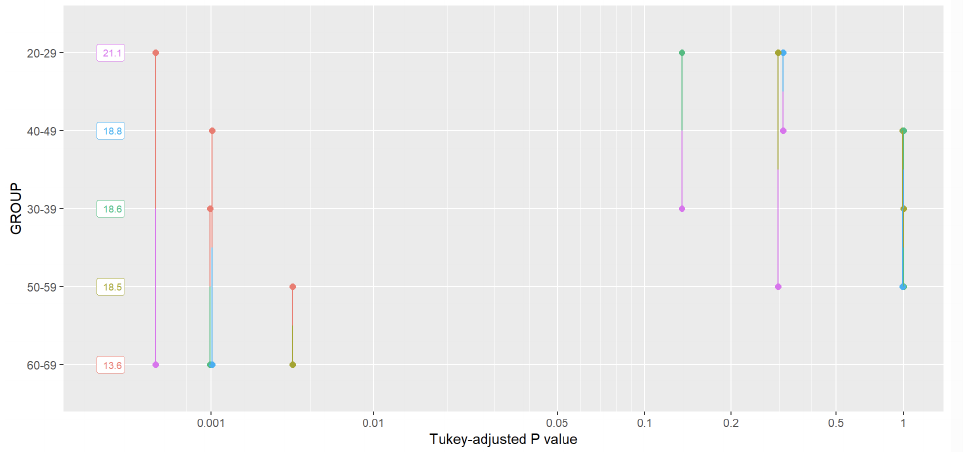
Figure 6. The MSE Tukey analysis results. Figure 7 illustrates the summary graph of the MSE analysis. The dots on the chart represent the averages, and the whiskers’ (thick lines) mean confidence intervals.